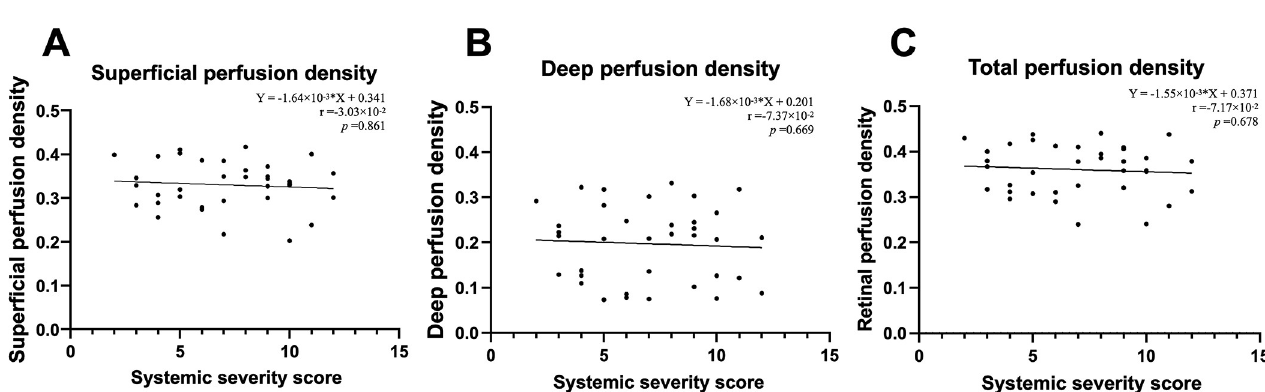
Fig 4. Spearman’s rank correlation analysis showed no significant correlations between the foveal avascular zone (FAZ) parameters ((A) FAZ size; (B) FAZ circularity) and the systemic severity score.